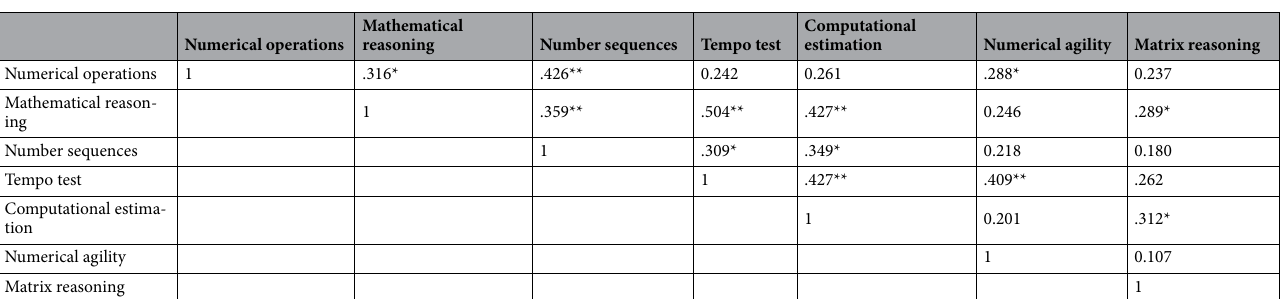
Table 2. Correlation matrix depicting the correlation coefficients between the numerical and matrix reasoning tests. *< 0.05 level (2-tailed), **< 0.01 level (2-tailed), uncorrected.